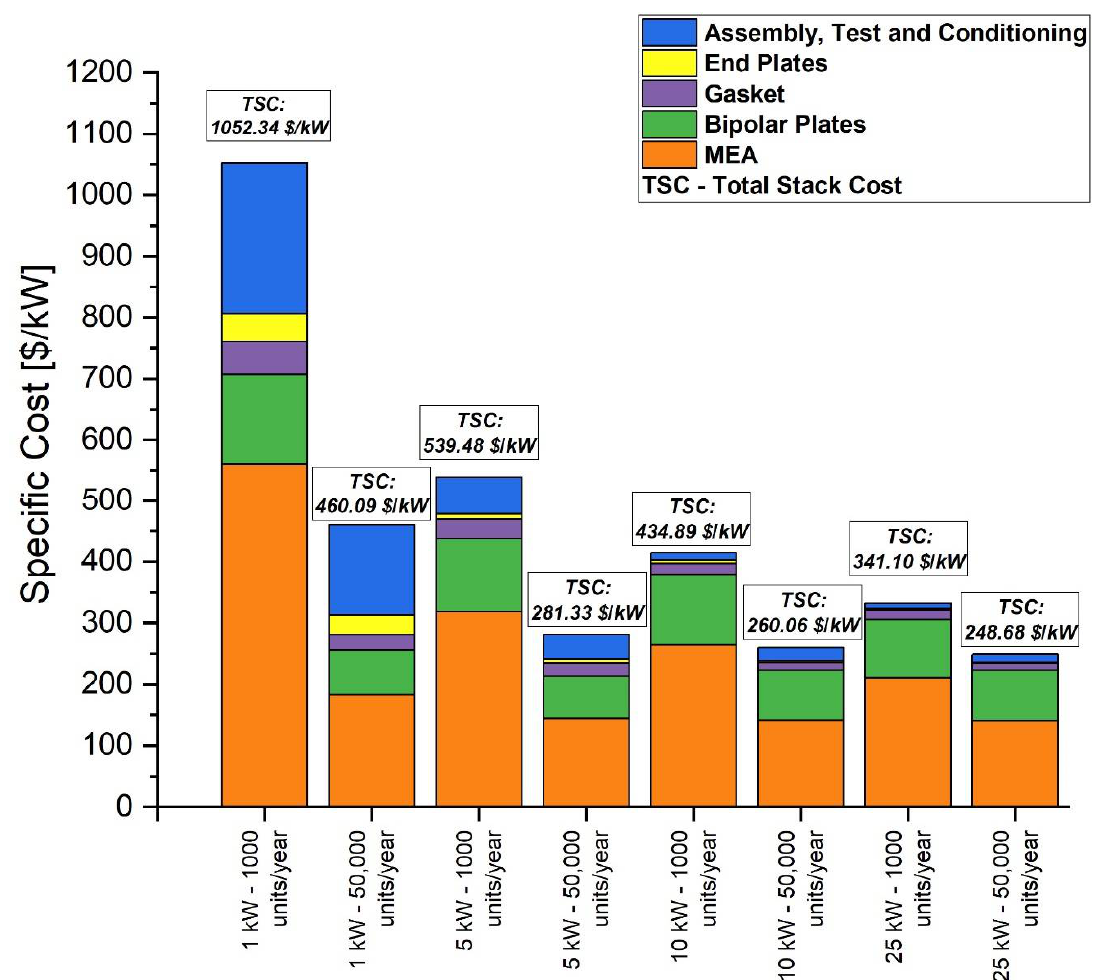
Figure 6. PEM Fuel Cell Stack Potential Cost Breakdown.